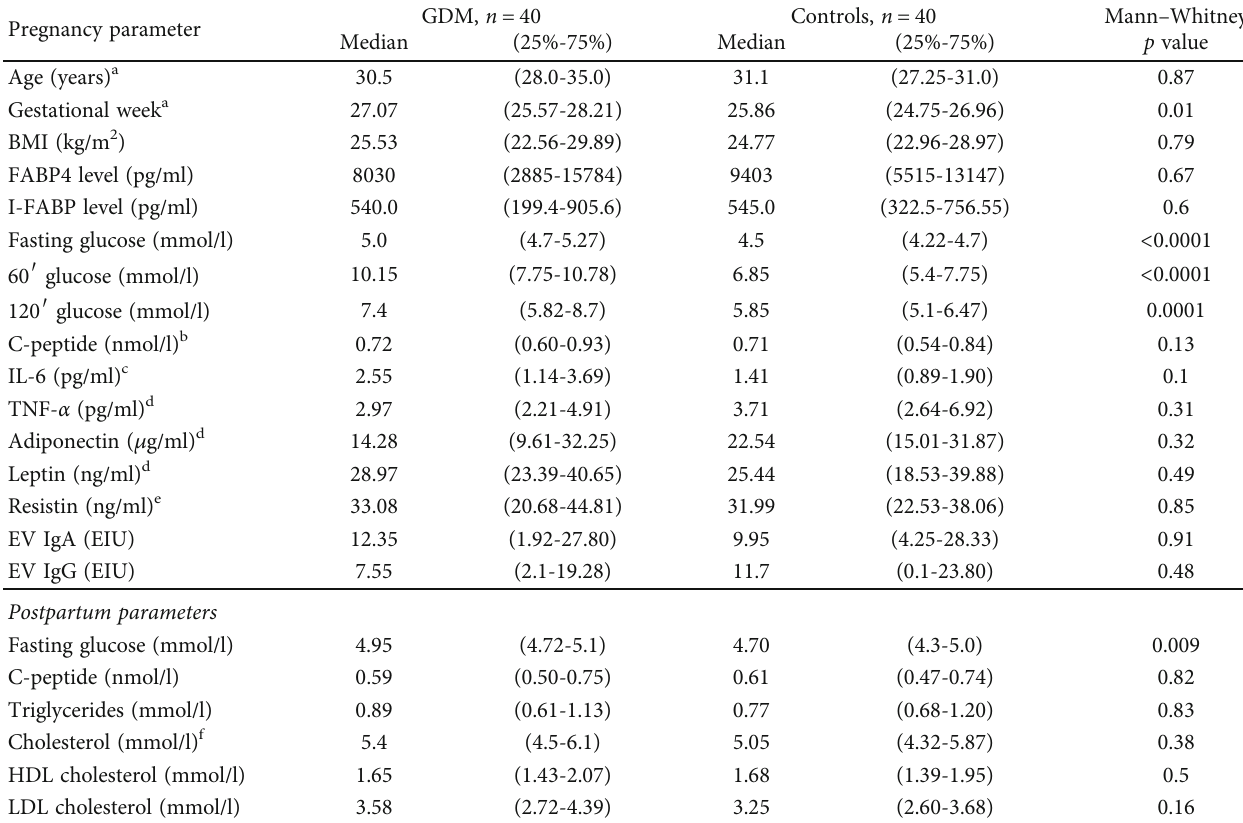
Table 1: Clinical parameters of patients with GDM and healthy pregnant control